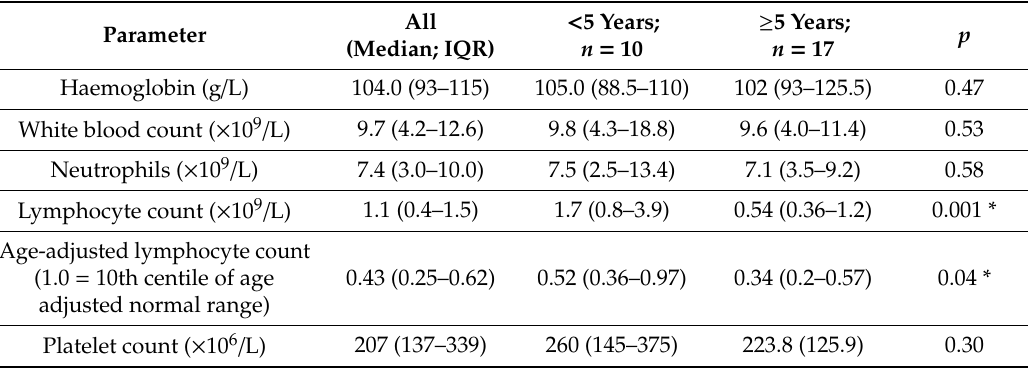
Table1. Median(interquartilerange)ofcompletebloodcountresultsatadmission, inchildrenpresenting with paediatric inflammatory multisystem syndrome temporally associated with SARS-CoV-2. Included is the age-adjusted lymphocyte count, expressed as a ration of patient’s absolute lymphocyte count divided by the 10th centile of age-adjusted normal lymphocyte